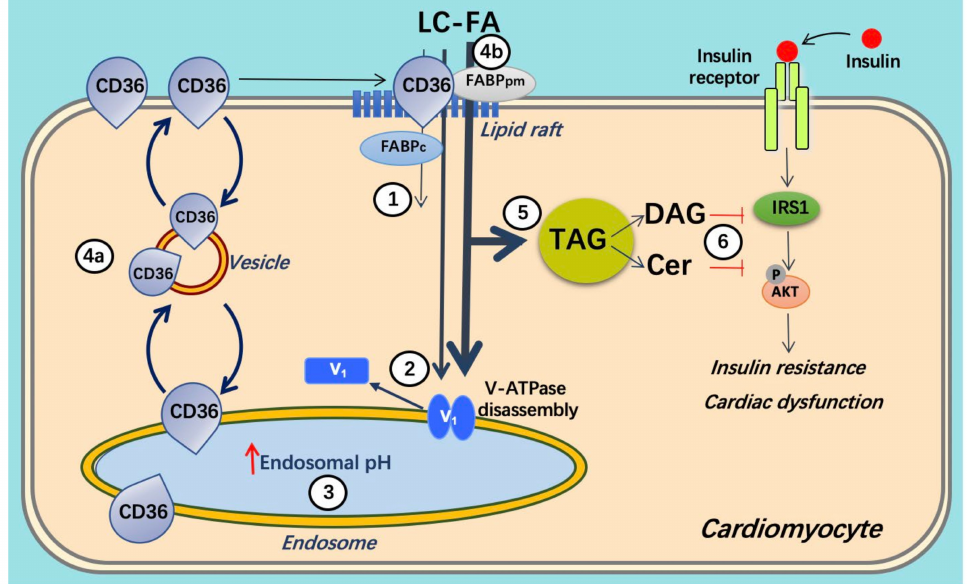
Figure 3. Schematic presentation of lipid oversupply-induced v-ATPase inhibition and its conse- quences for insulin sensitivity and contractile function. When long-chain fatty acid (FA, e.g., palmitate) supply is high, CD36 translocation from the endosome to the sarcolemma is stimulated. Furthermore, the v-ATPase V 0 sub-complex, which is integral to the endosomal membrane, is disassembled from the cytosolic V 1 sub-complex contributing to endosomal alkalinization (or increased endosomal pH). In this situation, the available FA is metabolized to meet the immediate energy demand. However, elevated extracellular FA supply triggers a series of events: (1) increased CD36-mediated FA uptake results in elevated intramyocellular FA levels, (2) FA causes the V 1 and V 0 subcomplexes to dissociate, (3) therefore, V 1 is shifted toward the cytoplasm. (4) The disassembly of v-ATPase leads to endosomal alkalinization. Increased endosomal pH triggers the translocation of CD36 vesicles to the sarcolemma. Upon chronic lipid oversupply, where FA uptake surpasses the metabolic needs, further processes are set in motion. (5) The lipid-induced increase in sarcolemmal CD36 feeds forward to further increased FA uptake and progressive lipid storage. (6) Lipid overload culminates in the loss of insulin sensitivity and contractile function. Adapted from